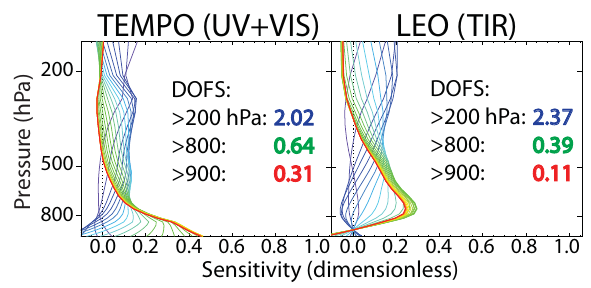
Figure 2. Normalized averaging kernel matrices assumed in this study (from Natraj et al., 2011) for clear-sky retrievals of tro- pospheric ozone from space in the UV + Vis (left) and the TIR (right). UV + Vis in our study corresponds to TEMPO, while TIR corresponds to a future LEO instrument flying concurrently with TEMPO. Lines are matrix rows for individual vertical levels, with the color gradient from red to blue corresponding to vertical levels ranging from surface air (red) to 200hPa (blue). Inset are the DOFS for the atmospheric columns below 200, 800, and